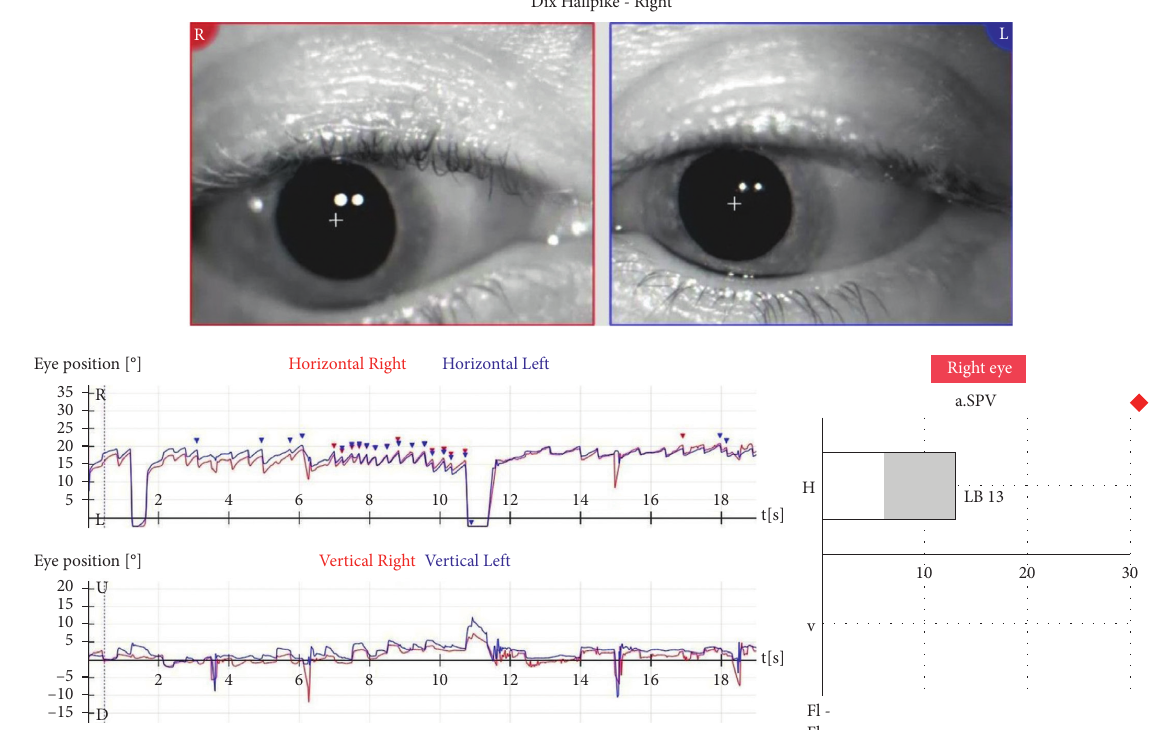
Figure 2: Right-sided Dix–Hallpike test performed during the initial VNG recorded horizontal ageotropic nystagmus of SPV 13 ° /s.